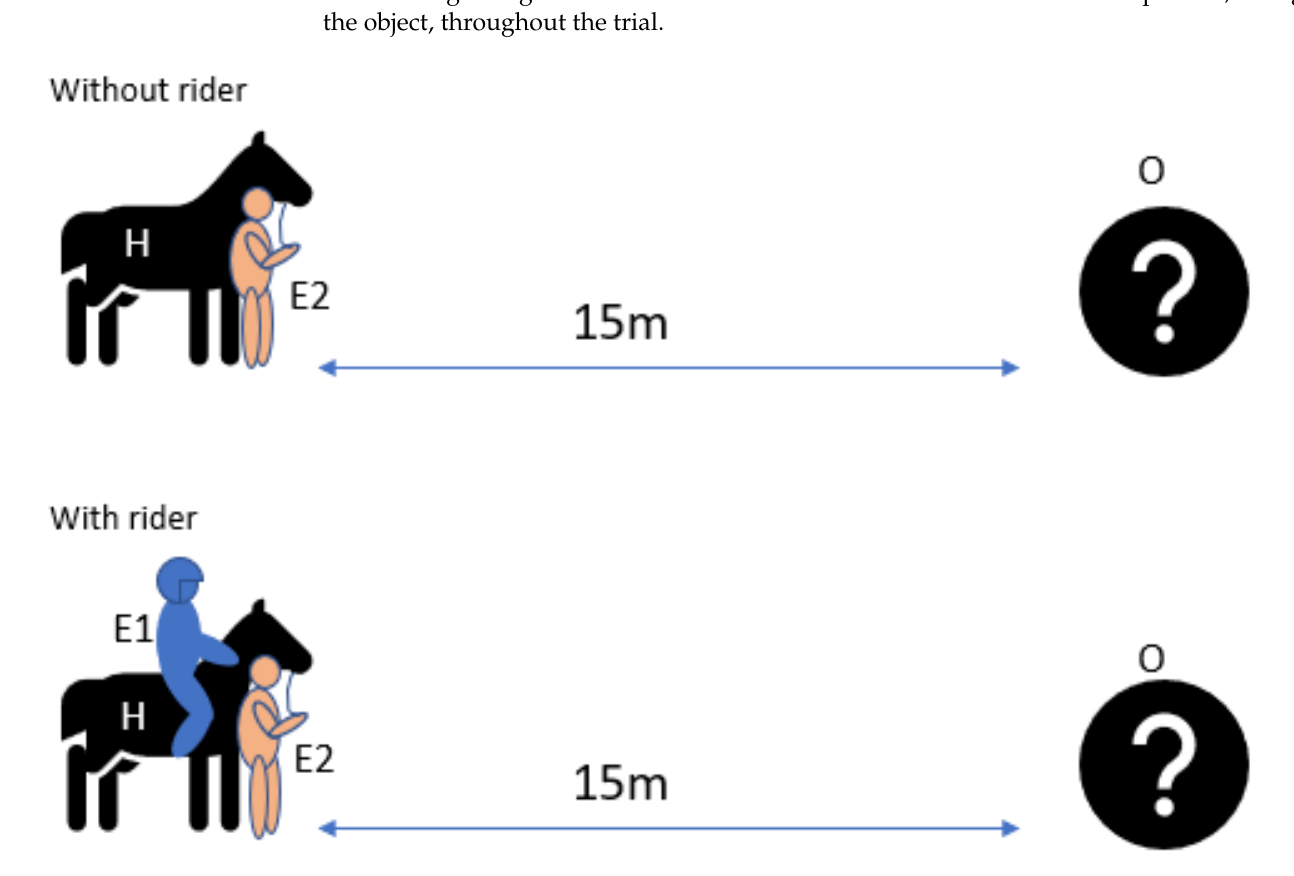
Figure 4. Setup of sensory laterality object test. The setup of the sensory laterality object test shows Experimenter 2 (E2) leading the horse (H) with and without a rider (E1) towards the object (O) from a 15 m distance.